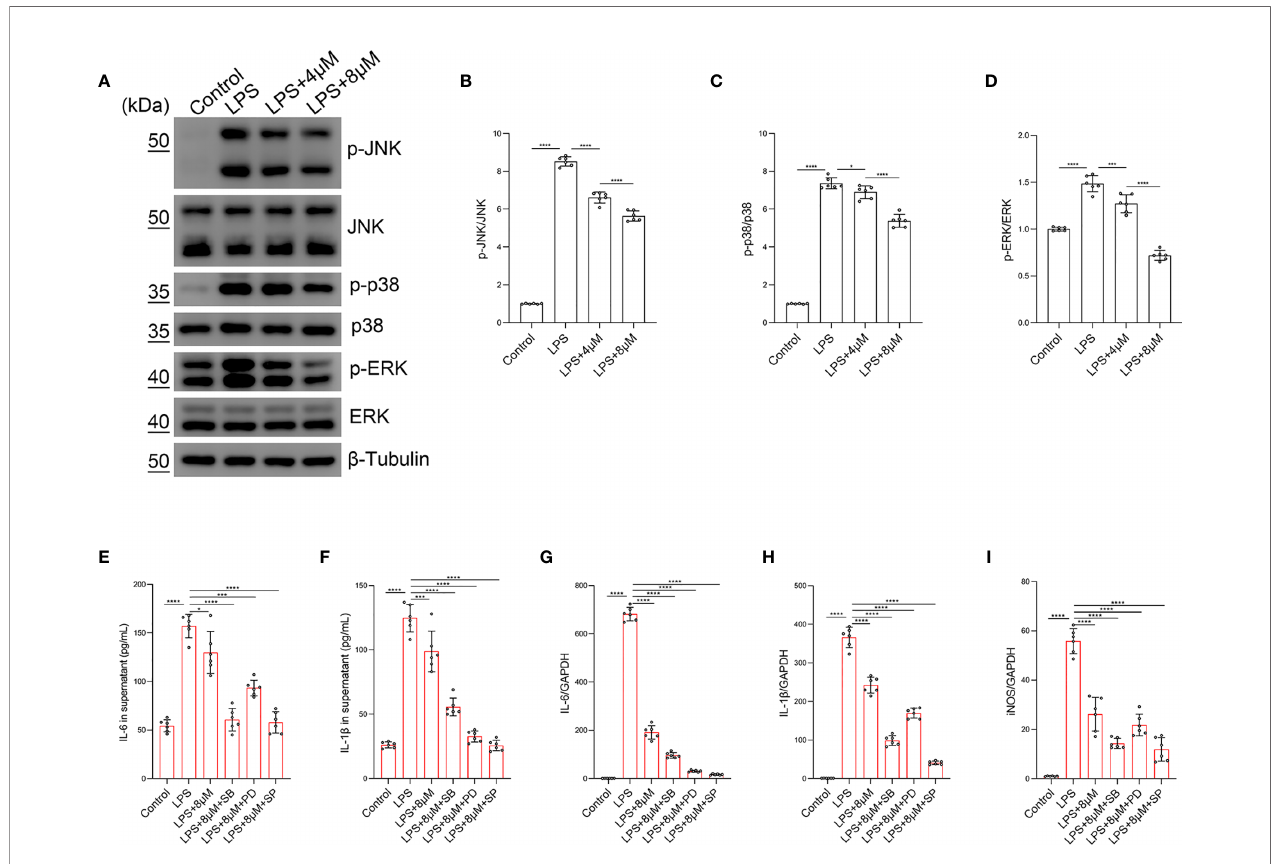
FIGURE 8 | Butorphanol inhibited M1 phenotype macrophage polarization through the MAPK signaling pathway. Macrophages were collected and cultured from the bone marrow of mice and treated with LPS (1 m g·mL -1 ) alone or butorphanol (4 m M or 8 m M) plus LPS (1 m g·mL -1 ) for 30 min. (A) The levels of phosphorylated MAPKs and their respective total proteins were measured by western blot analysis. (B – D) Densitometric analysis of the phosphorylated MAPKs levels in (A) was performed with normalization to the respective total proteins. Macrophages were incubated with LPS (1 m g·mL -1 ) alone, butorphanol (8 m M) plus LPS (1 m g·mL -1 ), the p38 inhibitor SB203580 (10 µM) plus LPS (1 m g·mL -1 ), the ERK inhibitor PD98059 (10 µM) plus LPS (1 m g·mL -1 ), or the JNK inhibitor SP600125 (10 µM) plus LPS (1 m g·mL -1 ) for 24 h. (E, F) IL-6 and IL-1 b protein levels in the supernatant of macrophage cultures were determined by ELISA. (G – I) The mRNA levels of IL-6, IL-1 b , and iNOS in cells were measured by qRT-PCR. The results are the means ± SEM of six independent experiments. Statistical analysis was performed by one- way ANOVA followed by Tukey ’ s post hoc test when comparing multiple independent groups. *P < 0.05, ***P < 0.001, ****P <